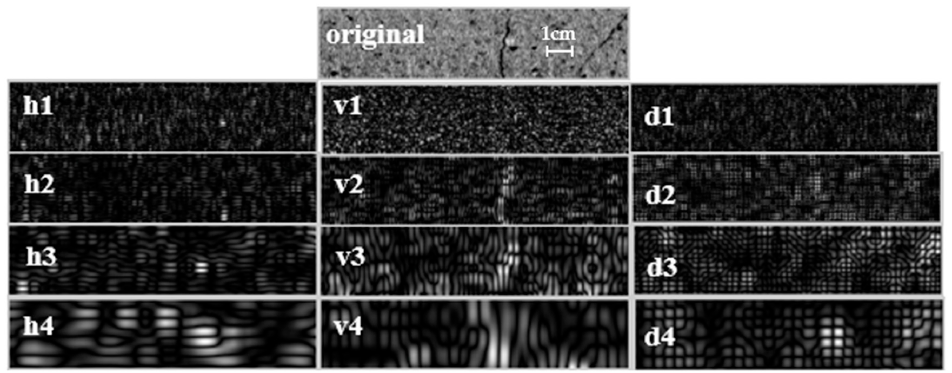
Figure 4. 2D Discrete wavelet decomposition of an X-ray image at four scales and in three directions.